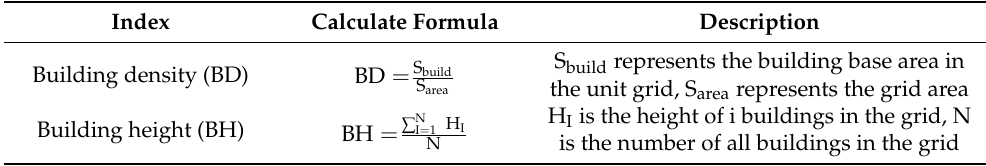
Table 2. Calculation of urban form parameters.